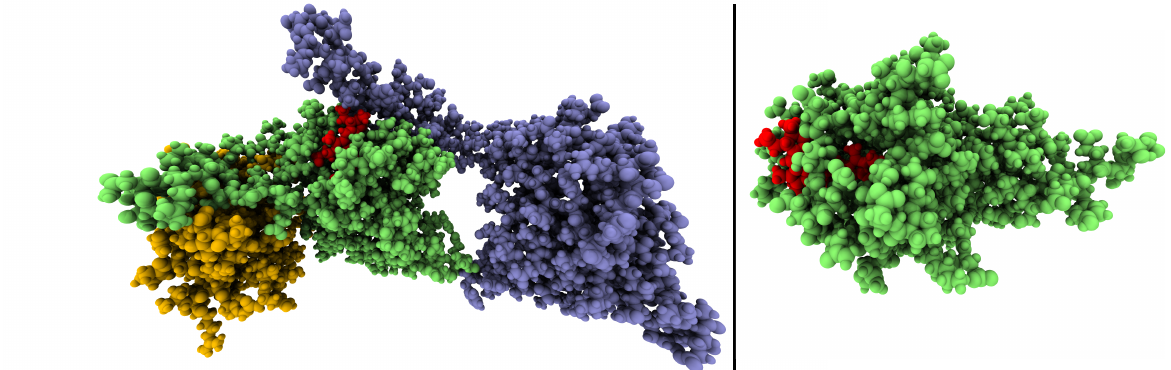
Figure 1. ( Left ) Sensory module of Cph1, a phytochrome of cyanobacterial origin. Phytochromes comprise a PAS (yellow)–GAF (green)–PHY (blue) tridomain, [16] wherein the latter acts as signal transmitter [10,35]. ( Right ) Photoactive GAF domain (green) of AnPixJ, a cyanobacteriochrome (CBCR) [13]. In both cases, the cofactor phycocyanobilin (PCB) is covalently bound to the GAF domain